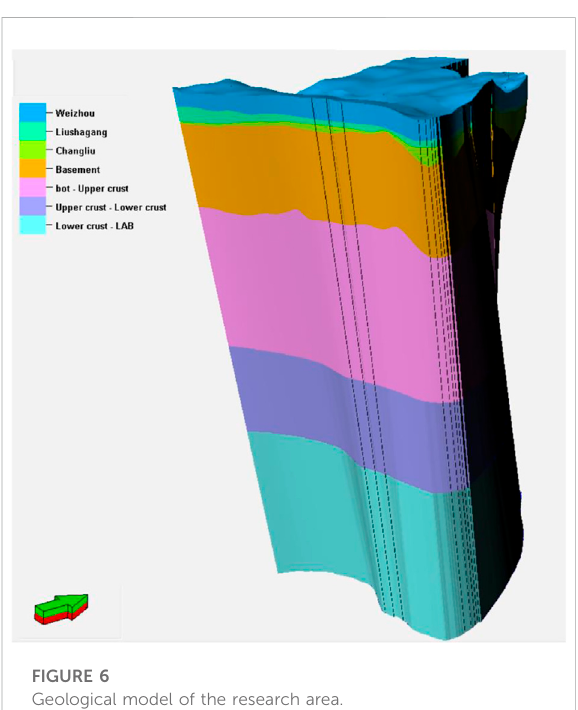
FIGURE 6 Geological model of the research